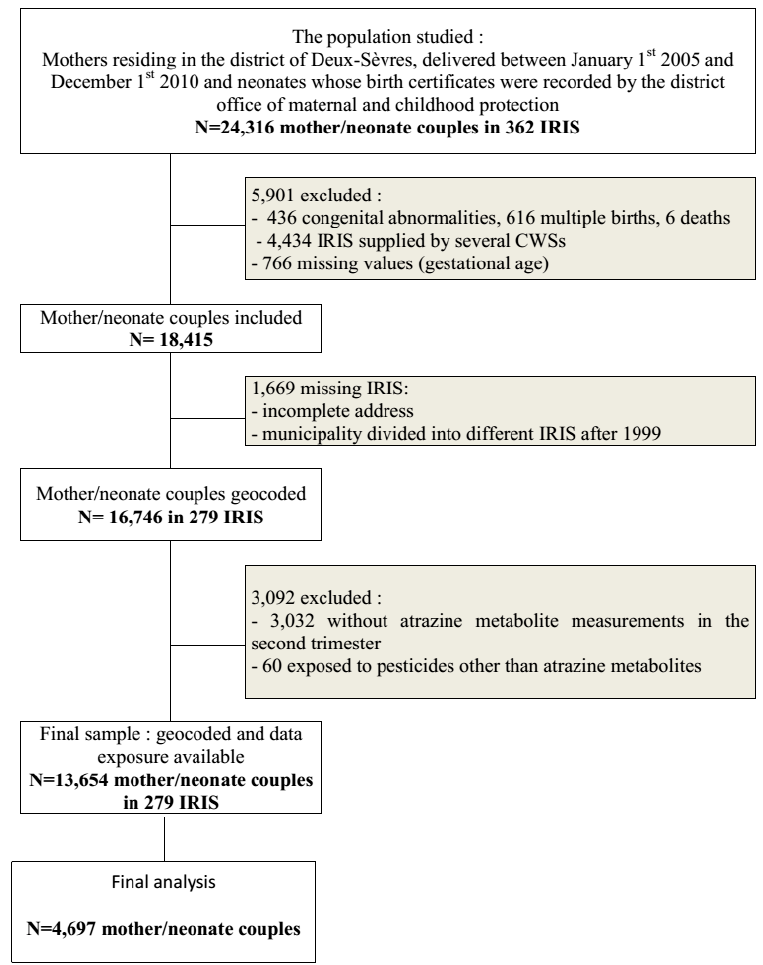
Figure 1. Flow chart of the population for studying the relation between exposure to atrazine metabolite in drinking-water and preterm birth, Deux-Sèvres, France, 2005–2010. Table 1. Prevalence of preterm birth babies according to population characteristics. Univariable analysis, Deux-Sèvres, France, 2005–2010. n = 13,654 mother/neonate pairs and 279 IRIS.